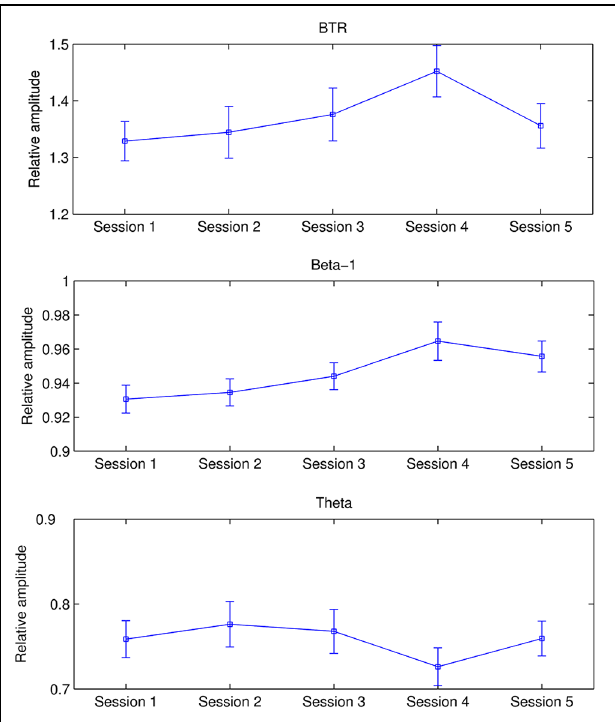
FIGURE 2 | Mean BTR, beta-1, and theta in each session. The error bars indicate SEM.